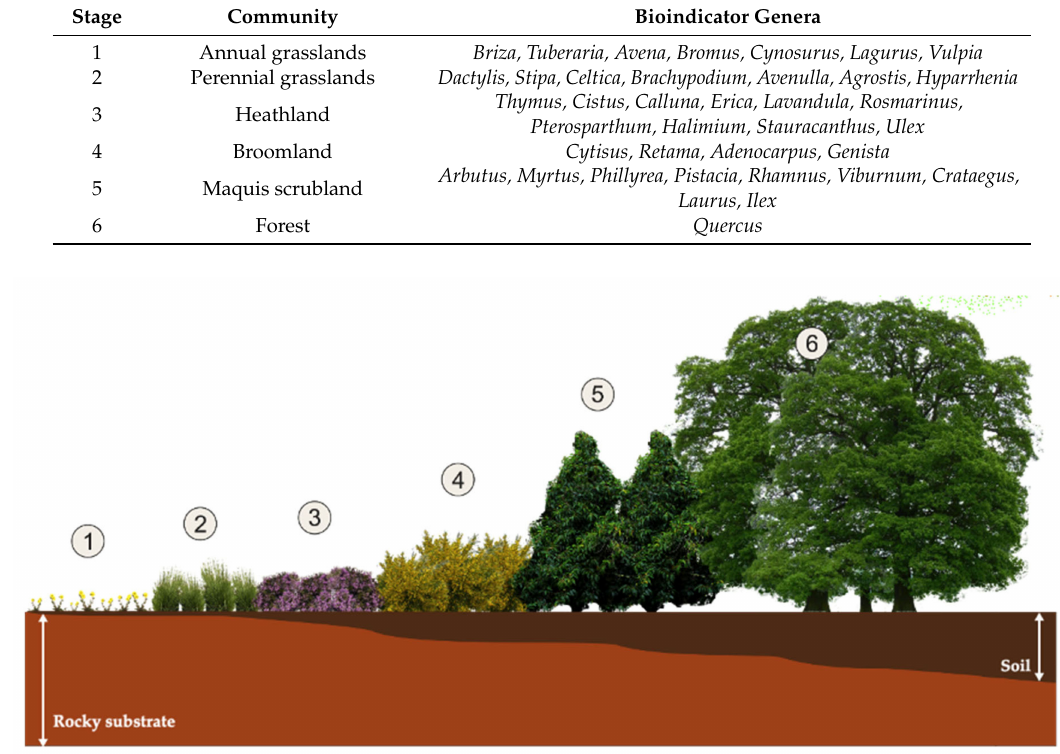
Table 1. Synthesis of the dynamic evolution of climatophilic vegetation cover in mainland Portugal.